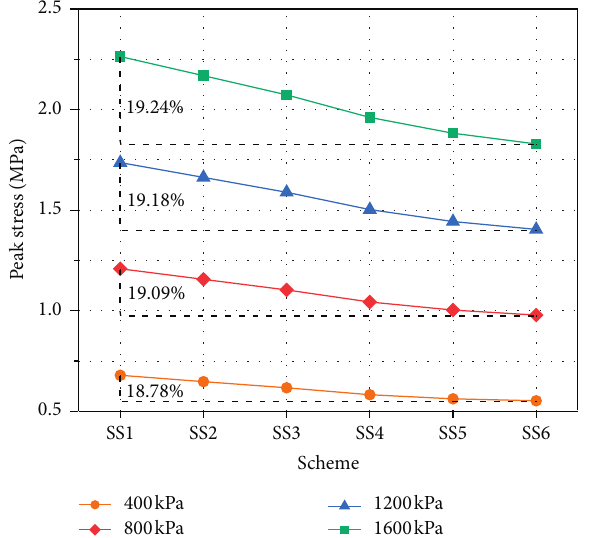
Figure 15: The mean value of peak stress in each